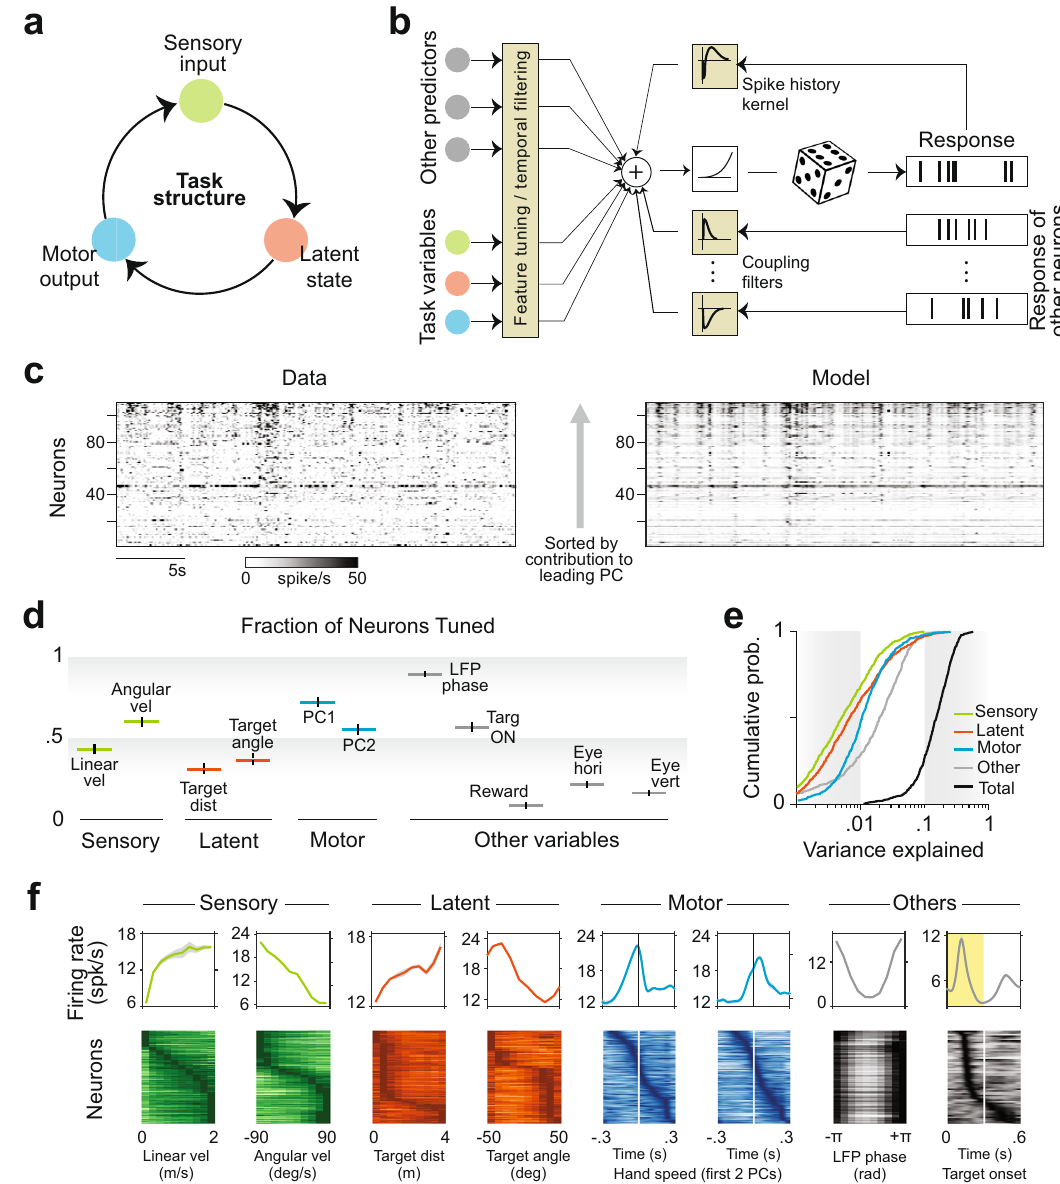
Fig. 3 | Neurons represent sensory variables, latent world states, and motor variables. a Causal structure of the task, illustrating the recurrent nature of the interaction between sensory inputs, latent states, and motor outputs. b Schematic of the generalized additive model (GAM) used to fi t spike trains of single neurons. c Activity of simultaneously recorded neurons during a random thirty second epoch during the experiment (left) and the corresponding prediction recon- structed using the model (right). Neurons are arranged according to their con- tribution to the leading principal component (PC) (bottom — lowest; top — highest) for visualization. d Proportion of neurons tuned to different variables. Error bars denote±1 standard error of binomial proportions ( n =244). e Cumulative